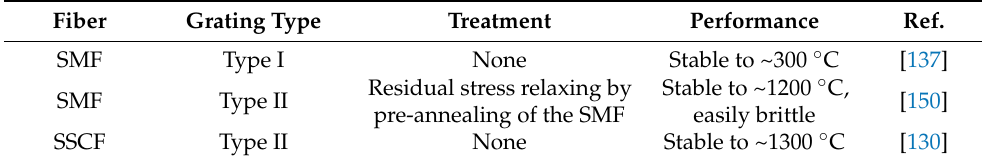
Table 5. Comparison of silica FBGs